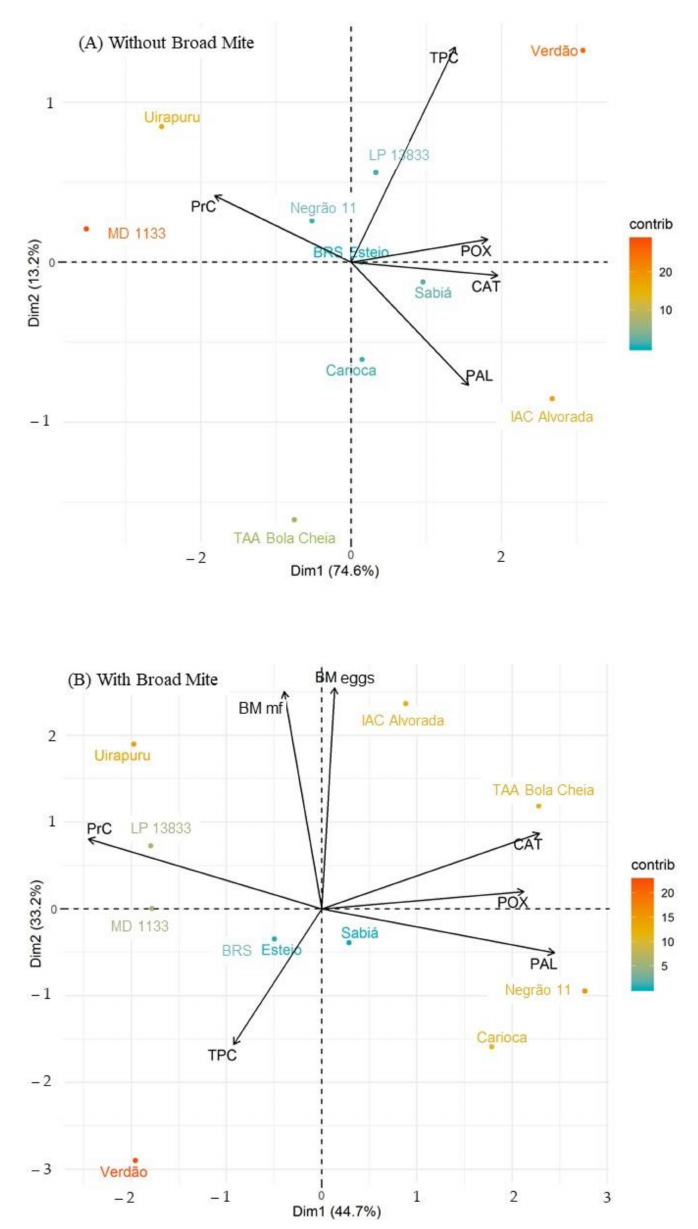
Figure 7. Analysis of principal components between the leaf contents of proteins (PrC), total phenolic compounds (TPC), catalase (CAT), peroxidase (POX), phenylalanine ammonia lyase (PAL), number of eggs of the broad mite Polyphagotarsonemus latus (BM eggs) and mobile forms (BM-mf) indicated by the eigenvector and common bean genotypes indicated by the eigenvalues in non-infested ( A ) and infested ( B ) with P. latus . Londrina-PR,